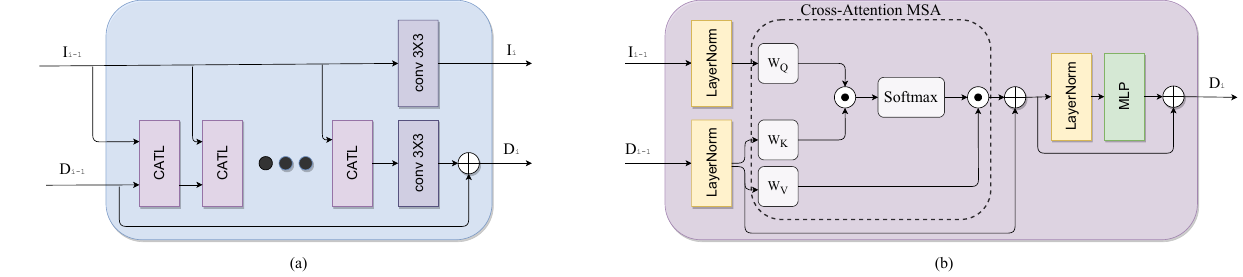
Figure 2. ( a ) Cross-Attention Transformer Block. ( b ) Cross-Attention Transformer Layer. To enable cross-window connections in consecutive layers, regular and shifted window partitionings are used alternately. In shifted window partitioning, features are shifted by M /2, M /2 pixels. Finally, the CATL can be formalized